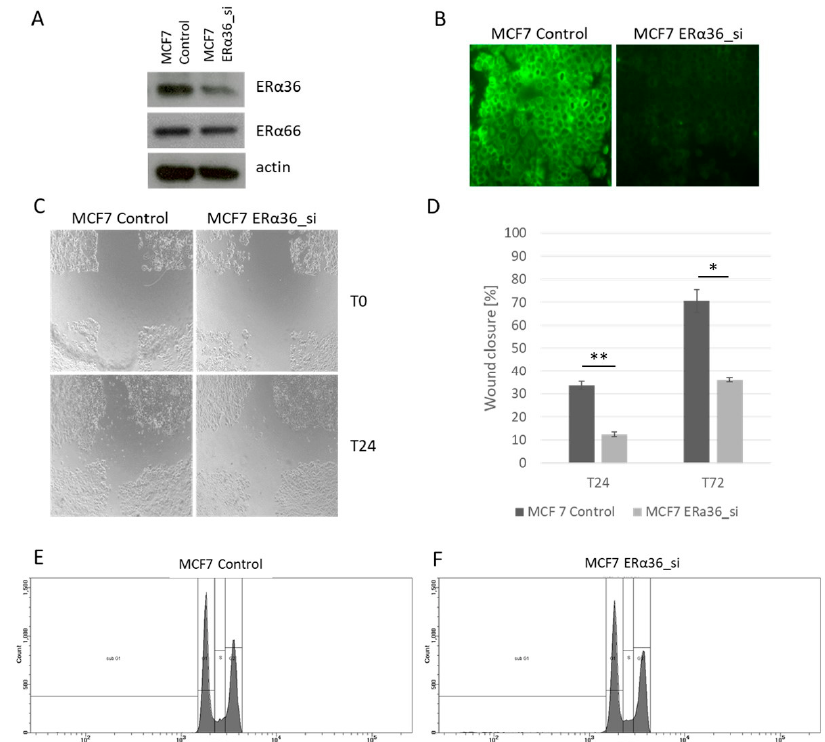
( B ). Decrease in cell migration measured by wound healing assay in cells with silenced ER α 36 ( C , D , * p = 0.005, ** p = 0.002). Cell cycle analysis by flow cytometry in the MCF7 wild-type cell line (MCF7 Control) and with ER α 36 silenced (MCF7 ER α 36_si) showed no di ff erences in the number of cells in a given cell cycle phase ( E , F